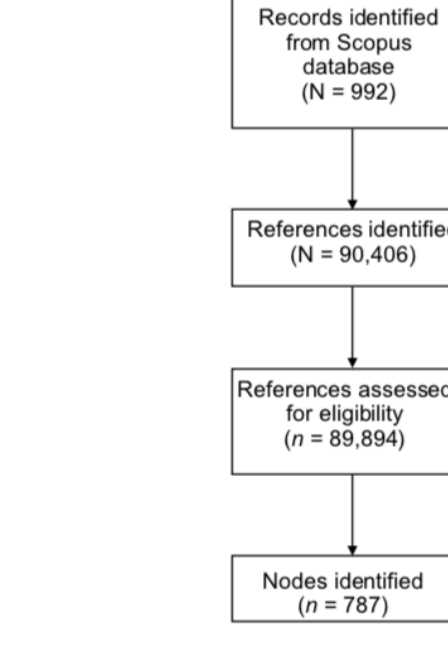
Figure 1. PRISMA flowchart of literature search, document co-citation analysis network generation and evaluation